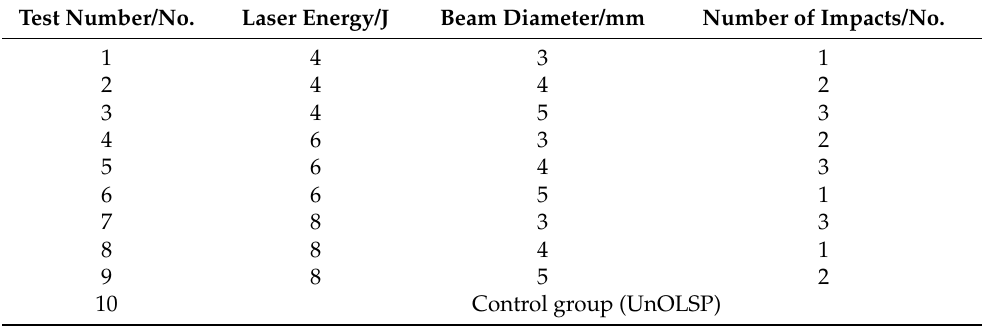
Table 3. Orthogonal test schedule.